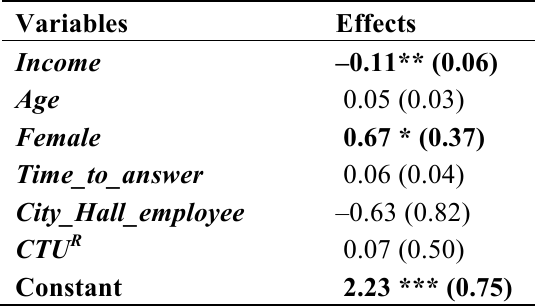
Table 5. Linear regression of risk aversion (defined as the safe choices) on socio-demographic